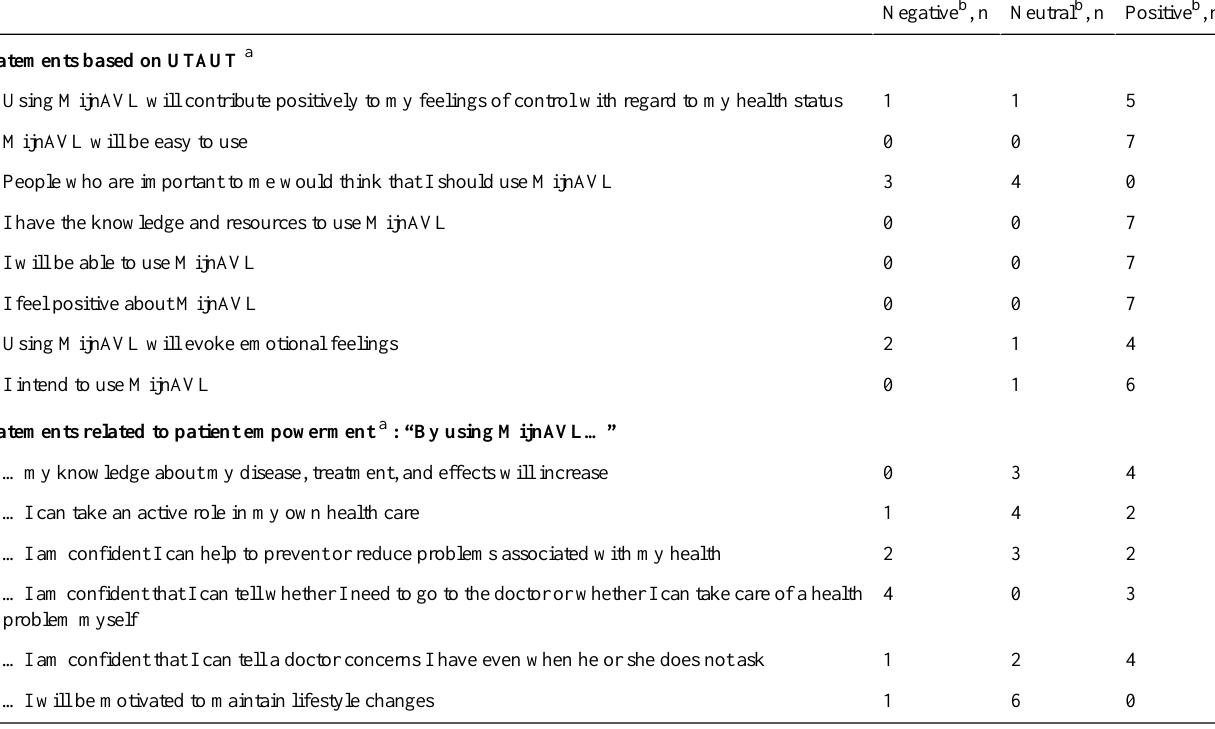
Table 3. Expectations based on UTAUT and expected effects on patient empowerment